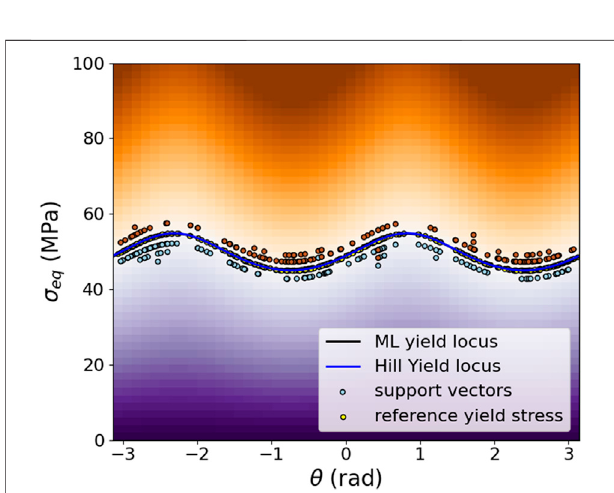
FIGURE 10 | Plot of trained SVM classi fi cation with optimized training size and ratio in cylindrical coordinates on the π -plane (space of principal deviatoric stresses). The fi gure annotations are identical to Figure 5 .